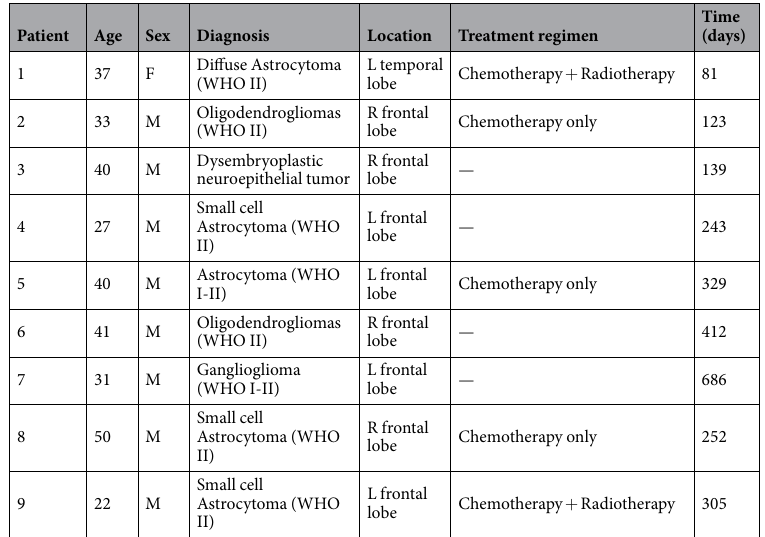
Table 1. Summary of the 9 patients’ data included in this